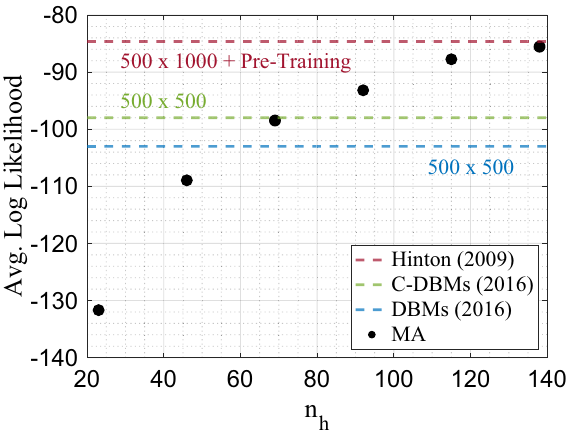
Figure 4. Average log-likelihood on the MNIST data set achieved after 100 epochs with mode-assisted training (MA) compared to the recent best achieved results on DBMs using CD as well as pre-training. DBMs trained with MA used PCD-1 for all non-modal samples, matching Ref. 18 . Network topology was fixed to α = 0.15 with an increasing number of hidden nodes, n h . The learning rate was chosen to follow a linear decay, ǫ = 0.05 → 0.0005 and no pre-training was employed. The best log-likelihood was reported out of 10 randomly initialized